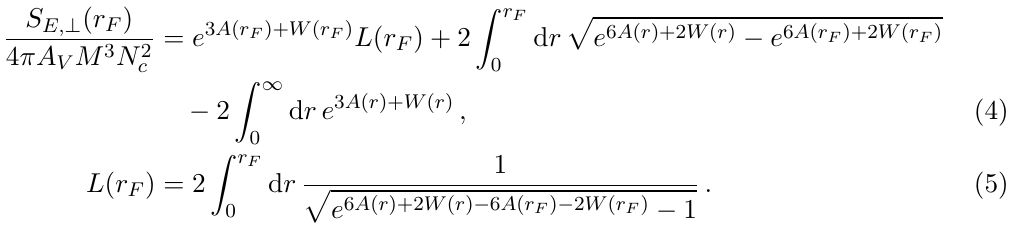
Figure 1 . Entanglement entropy S of [1], for x = 1 and di(cid:11)erent values of a . Note that each curve has multiple branches.